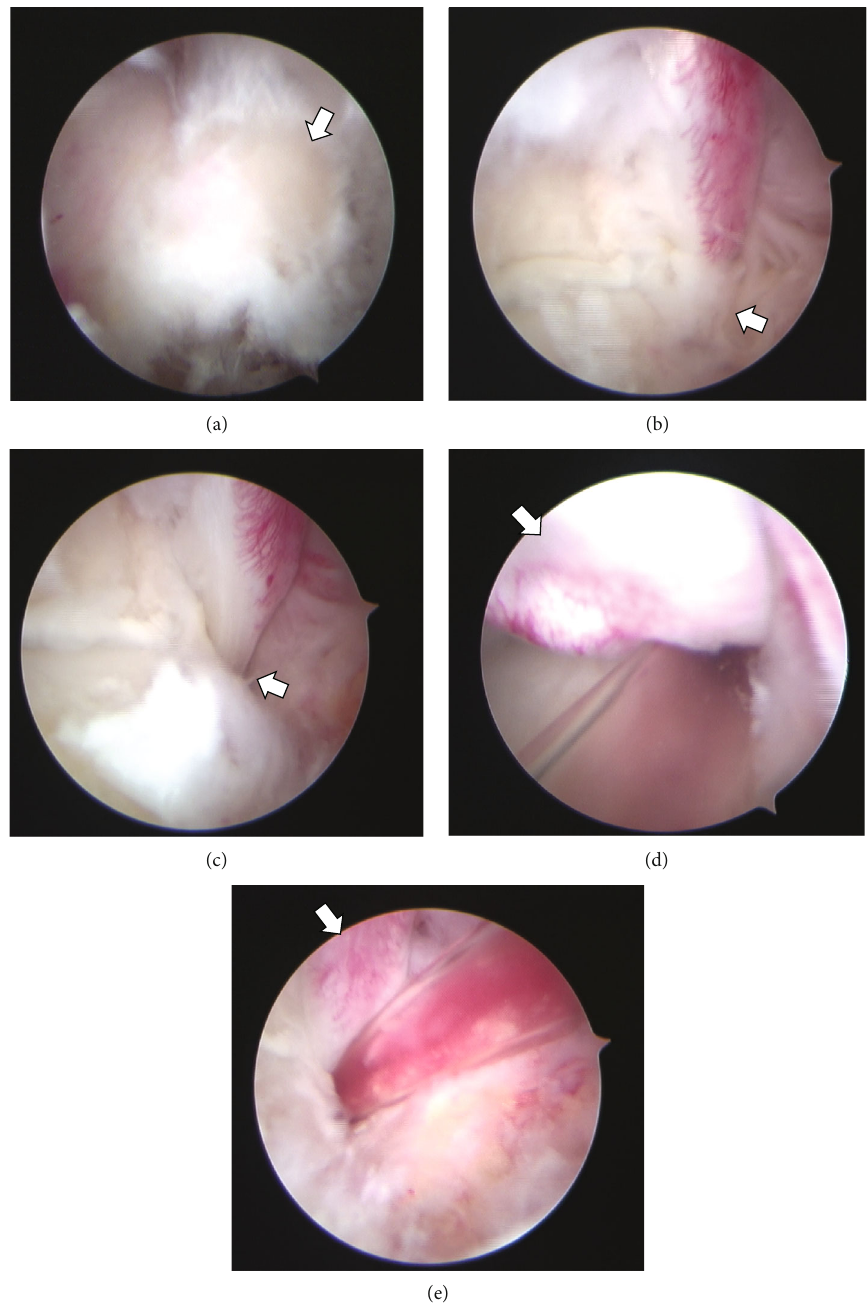
Figure 5: Arthroscopic views of the posterior aspect of the left ankle. (a) The posterior aspect of the os trigonum (arrow) can be visualized. (b) The fi brous portion of the tunnel compressed the fl exor hallucis longus (FHL) tendon (arrow) after removal of the os trigonum. (c) Stenosis was not seen (arrow) after the release of the FHL tendon. Suction was performed along the FHL tendon (d) toward a level proximal to the ankle joint posteriorly and (e) anterior to the talar tubercles and the master knot of